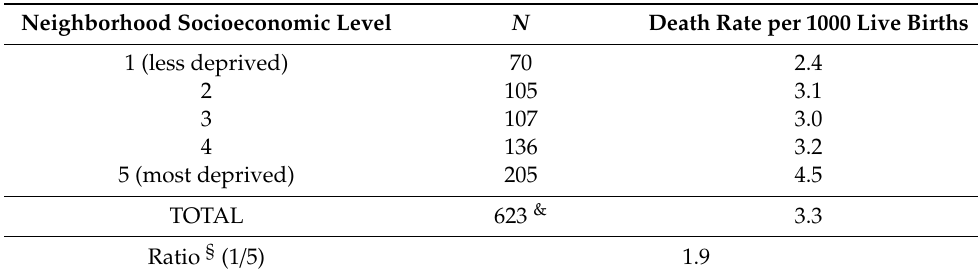
Table 3. Infant deaths by neighborhood socioeconomic level: Paris 2004–2009.